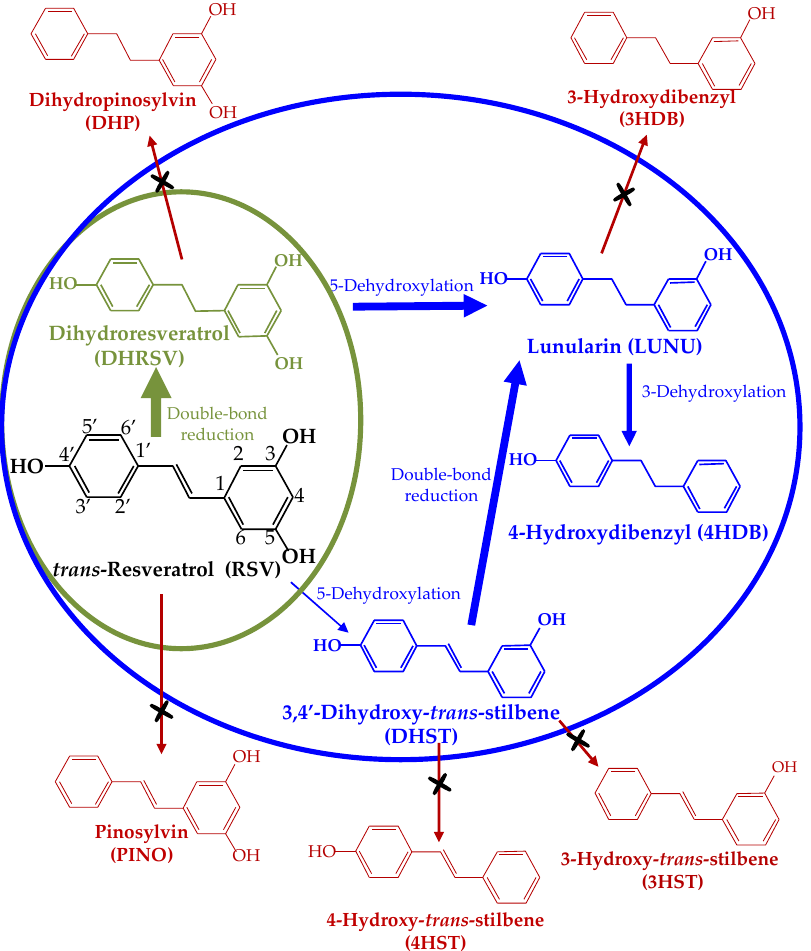
Figure 11. Metabolism of RSV by the human gut microbiota (adapted from [15]). Green circle, LUNU non-producer metabotype; blue circle, LUNU-producer metabotype; red compounds, metabolites not produced in humans [15].